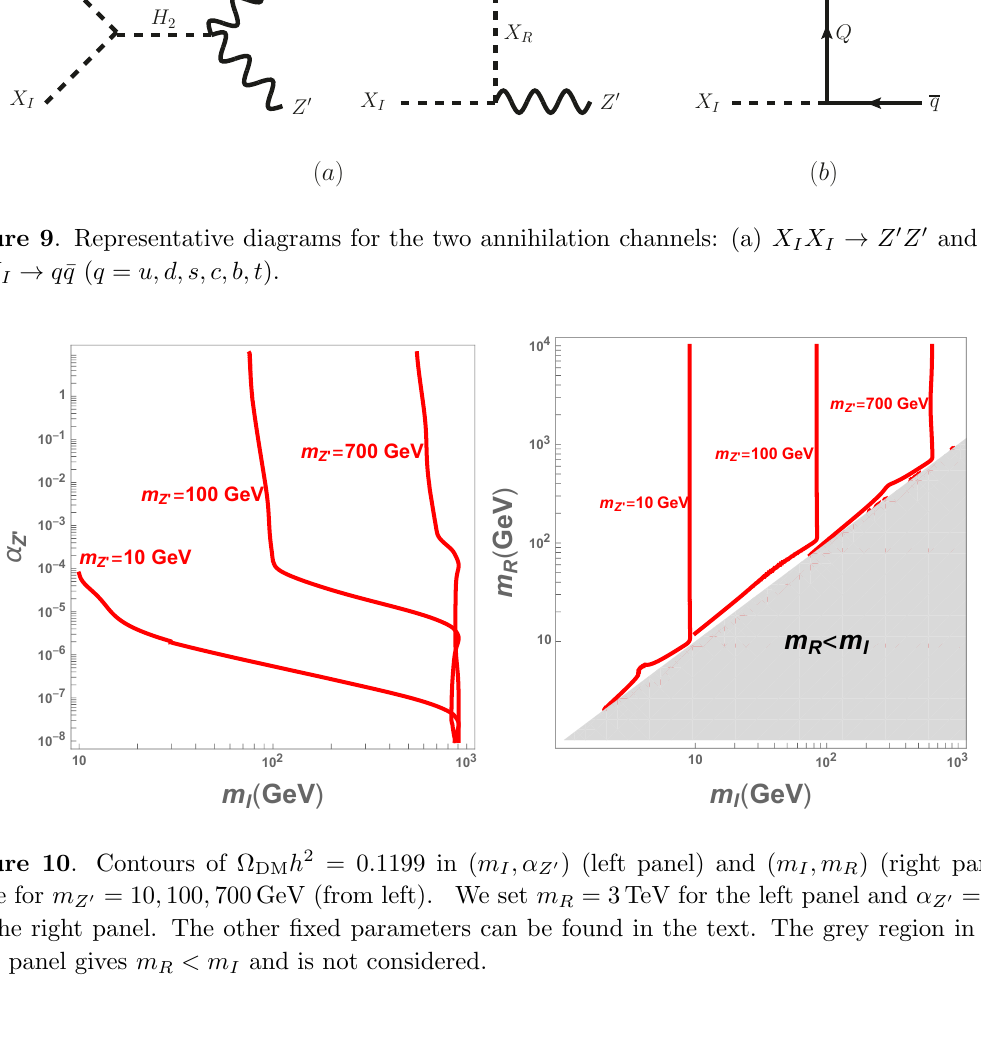
Figure 10 . Contours of (cid:10) DM h 2 = 0 : 1199 in ( m I ; (cid:11) Z 0 ) (left panel) and ( m I ; m R ) (right panel) plane for m Z 0 = 10 ; 100 ; 700 GeV (from left). We set m R = 3 TeV for the left panel and (cid:11) Z 0 = 0 : 1 for the right panel. The other (cid:12)xed parameters can be found in the text. The grey region in the right panel gives m R < m I and is not